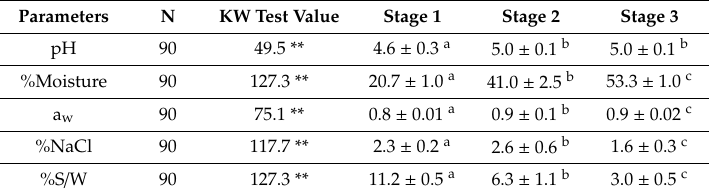
Table 1. Descriptive statistics (Median ± Interquantile Range) for chemical determinations, overall and by ripening stage, and di ff erences between ripening stages.